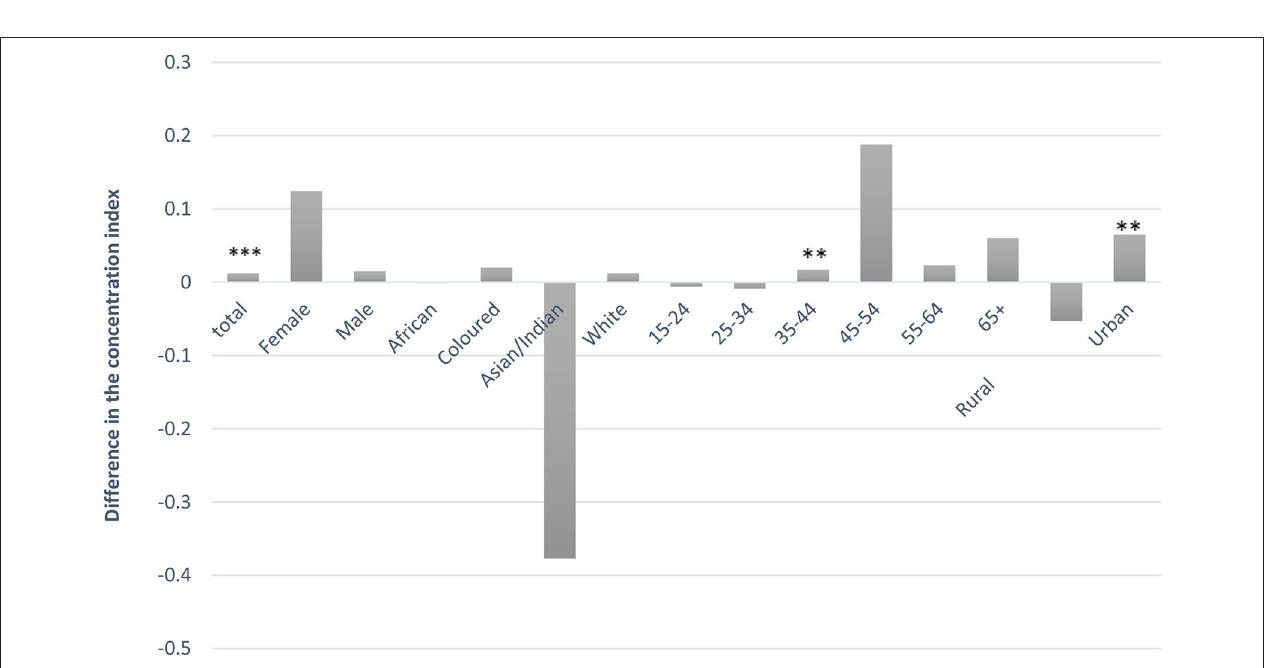
FIGURE 2 | Difference in the concentration index of binge drinkers between 2008 and 2014/15. A positive value signifies a pro-rich “shift” while a negative value signifies a pro-poor “shift.” Significance levels are denoted as follows: *** p < 0.01, ** p < 0.05, and * p < 0.10. ªAn adult (female or male) who is a current alcohol drinker consuming five or more standard drinks on a single